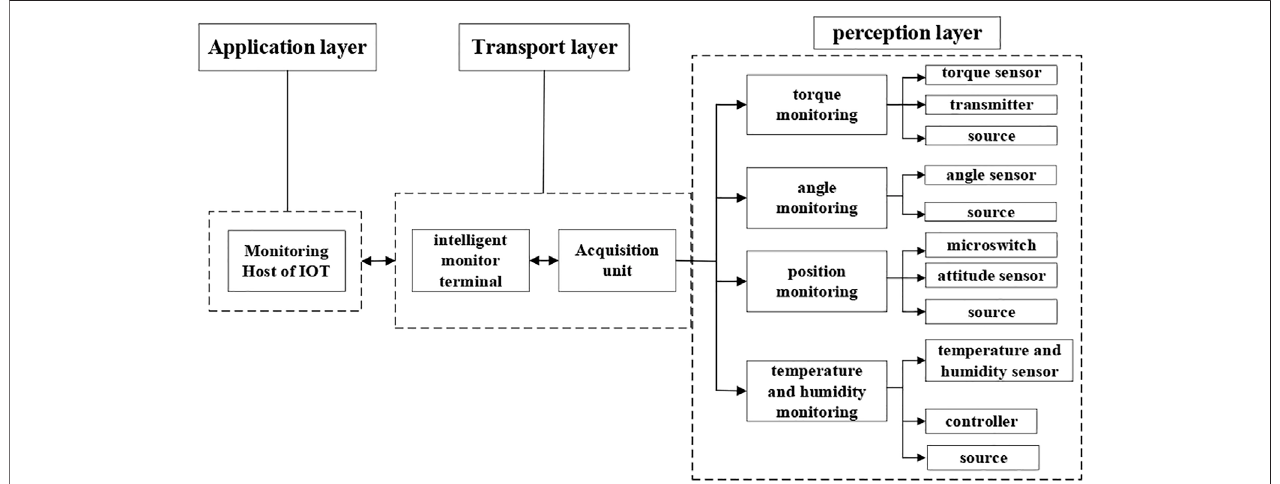
FIGURE 4 | Hardware structure diagram.